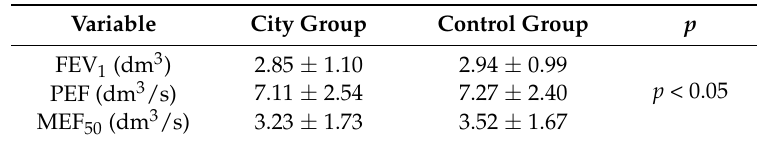
Table 3. Mean values and standard deviations of the absolute values of basic spirometric parameters in the city and control group.